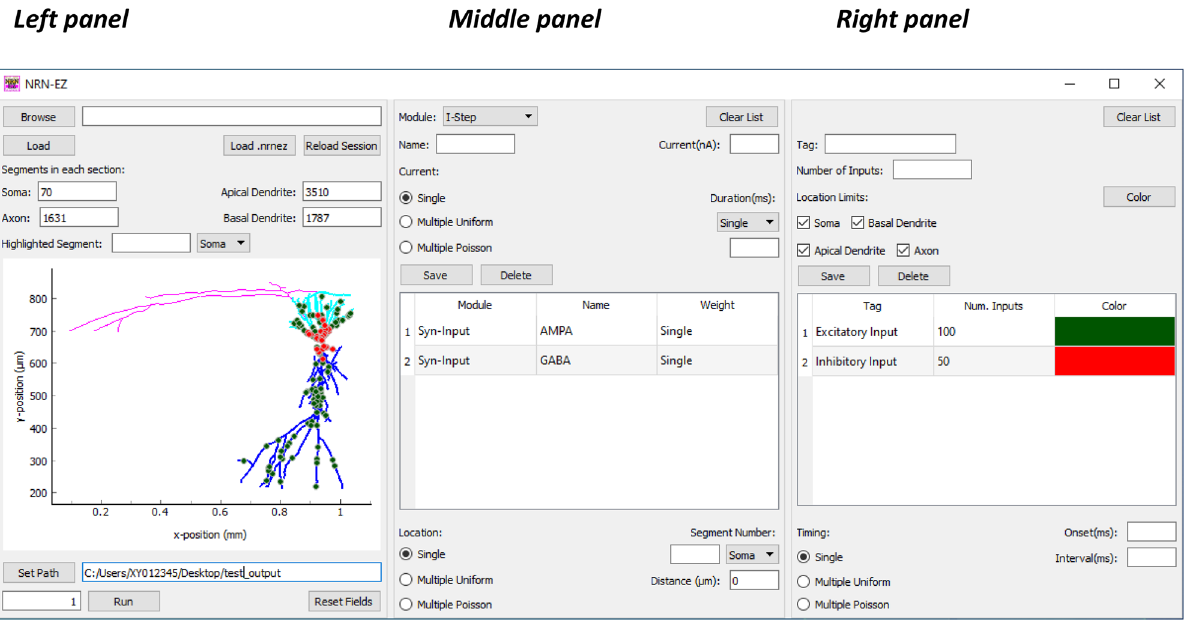
Figure 1. The NRN-EZ GUI. The GUI is composed of a left, middle, and right panel. The left panel allows users to upload a file containing information about the 3D neuron structure. Once the upload is finished, the users can see the number of segments in each of the four sections of the neuron. They can also pan through the neuron morphology, identify specific segments, and set the path to the directory, which will contain the output from NRN-EZ. The middle panel is the one through which users specify the type of module they plan to use: current steps or synaptic stimulations. They can use multiple modules and assign them an arbitrary name. The weight, kinetics and timing of activation can be selected through the parameters described in the upper portion of the panel. The bottom portion allows users to select the location and spatial distribution of these inputs. The right panel allows selecting the number of inputs and the limits for their spatial location. For example, one may decide to confine synaptic inputs of a given type only to one dendritic compartment. NRN-EZ allows selecting multiple types of inputs, with unique locations and weights that can be integrated to run NEURON simulations of synaptic integration. The neuron morphology loaded in the GUI has color-coded sections and synaptic inputs.